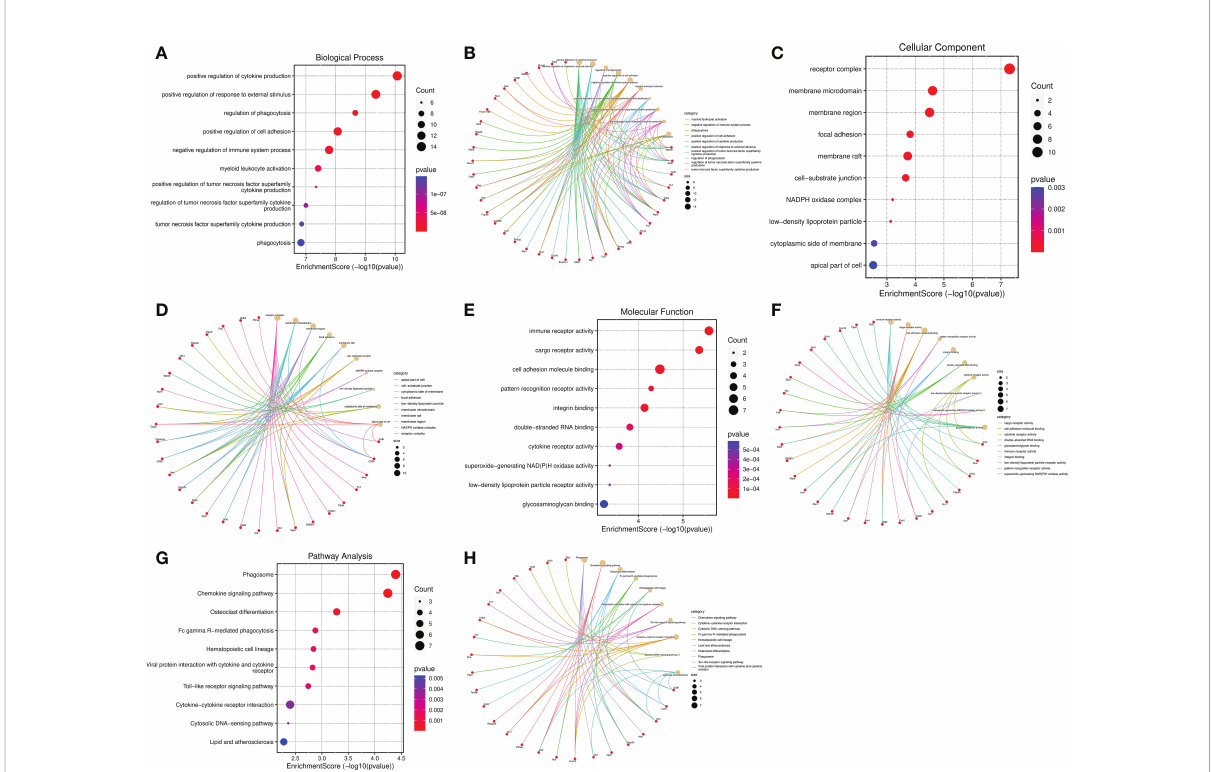
FIGURE 7 Functional and pathway enrichment analysis of the IRGs related to SCI. (A – F) Bubble diagram and cnetplot showing the host genes of DECs enriched in the different GO categories, including BP, CC, and MF. (G, H) KEGG pathway enrichment analysis of the host genes of